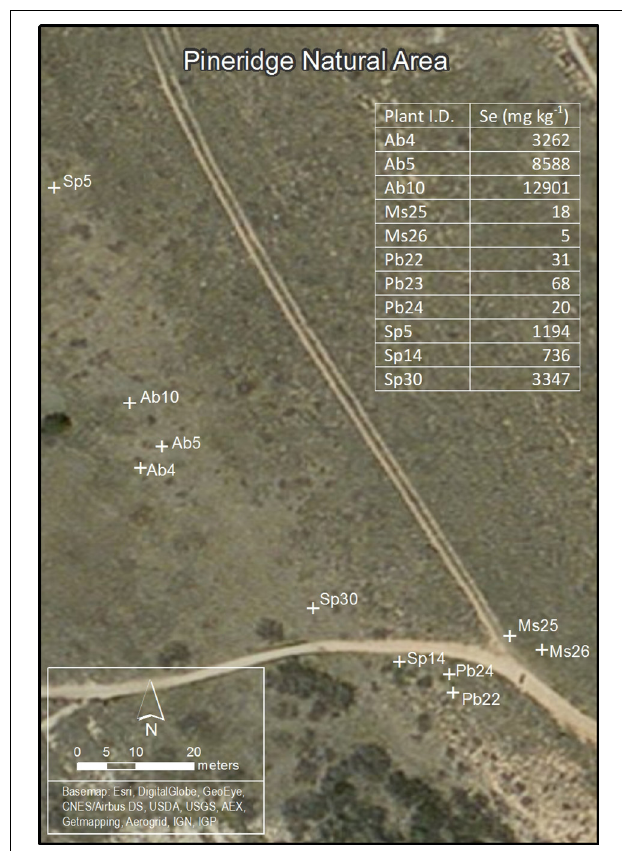
FIGURE 1 | Map of Pineridge Natural Area, the seleniferous site west of Fort Collins, CO, USA where plants were sampled for T-RFLP analysis. Ab4, Ab5, Ab10—three individual plants of Astragalus bisulcatus (hyperaccumulator); Sp5, Sp14, Sp30—three individual plants of Stanleya pinnata (hyperaccumulator); Ms25, Ms26—two individual plants of Medicago sativa (non-hyperaccumulator); Pb22, Pb23, Pb24—three individual plants of Physaria bellii (non-hyperaccumulator). The table insert lists the leaf Se concentration for every plant sampled.